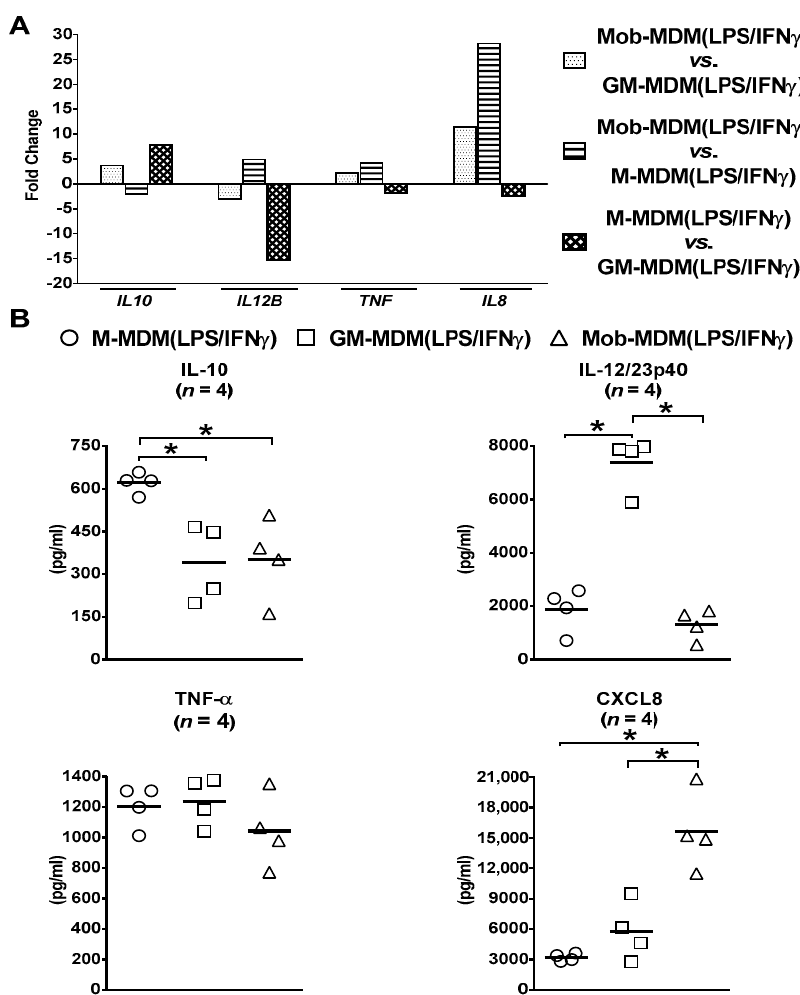
Figure 3. Confirmation of select cytokines and chemokines identified to be differentially expressed among lipopolysaccharide (LPS)/interferon γ (IFN γ )-activated monocyte-derived macrophages (MDMs) by RNA sequencing (RNA-Seq). Macrophage colony-stimulating factor MDMs (M-MDMs), granulocyte/macrophage colony-stimulating factor MDMs (GM-MDMs), and heat-killed Mycobacterium obuense MDMs (MobMDMs) were generated and were activated with LPS/IFN γ for 24 h (as described in the Materials and Methods section (Section 4)). The differential expression of ( A ) select cytokine/chemokine transcripts, namely interleukin 10 ( IL10 ) (encodes IL-10), IL12B (encodes IL-12/23p40), tumor necrosis factor ( TNF ) (encodes TNF- α ), and IL8 (encodes chemokine C-x-C motif ligand 8 (CXCL8)), in LPS/IFN γ -activated MDMs was confirmed at ( B ) the protein level by analysis of their secreted levels in M-MDM(LPS/IFN γ ), GM-MDM(LPS/IFN γ ), and Mob-MDM(LPS/IFN γ ) culture supernatants by ELISA. ( A ) Column bars represent fold change for each cytokine or chemokine transcript, and ( B ) scatter plots demonstrate cytokine or chemokine concentration in culture supernatants of the three LPS/IFN γ -activated MDM types. The same MDMs were used for RNA-Seq and ELISA experiments. Horizontal bars indicate group mean values of cytokine or chemokine concentration of at least 4 independent donors. One-way ANOVA, followed by Tukey’s post-hoc test, was performed to determine statistically significant differences in cytokine/chemokine secreted levels (* p < 0.05). Circles represent M-MDM(LPS/IFN γ ), squares represent GM-MDM(LPS/IFN γ ) and triangles represent Mob-MDM(LPS/IFN γ ).